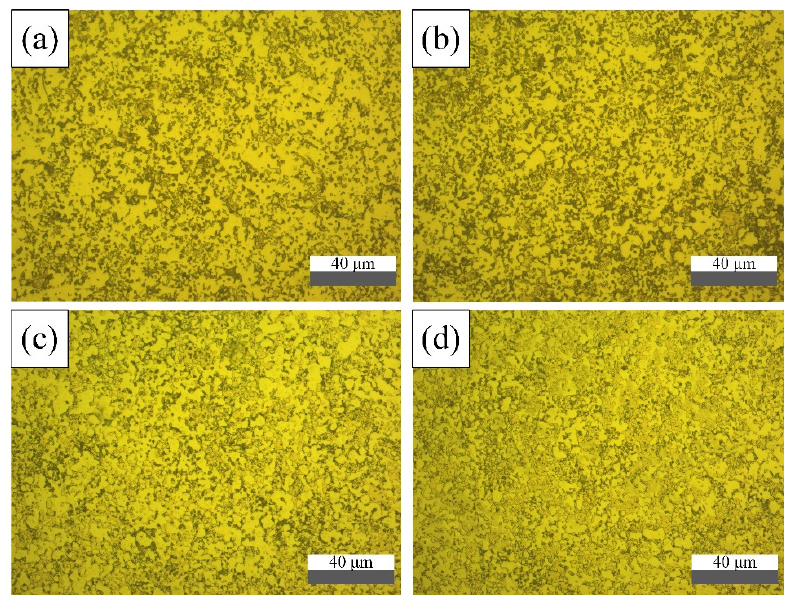
Figure 2. XRD diffraction patterns for alloys with different Zr contents .